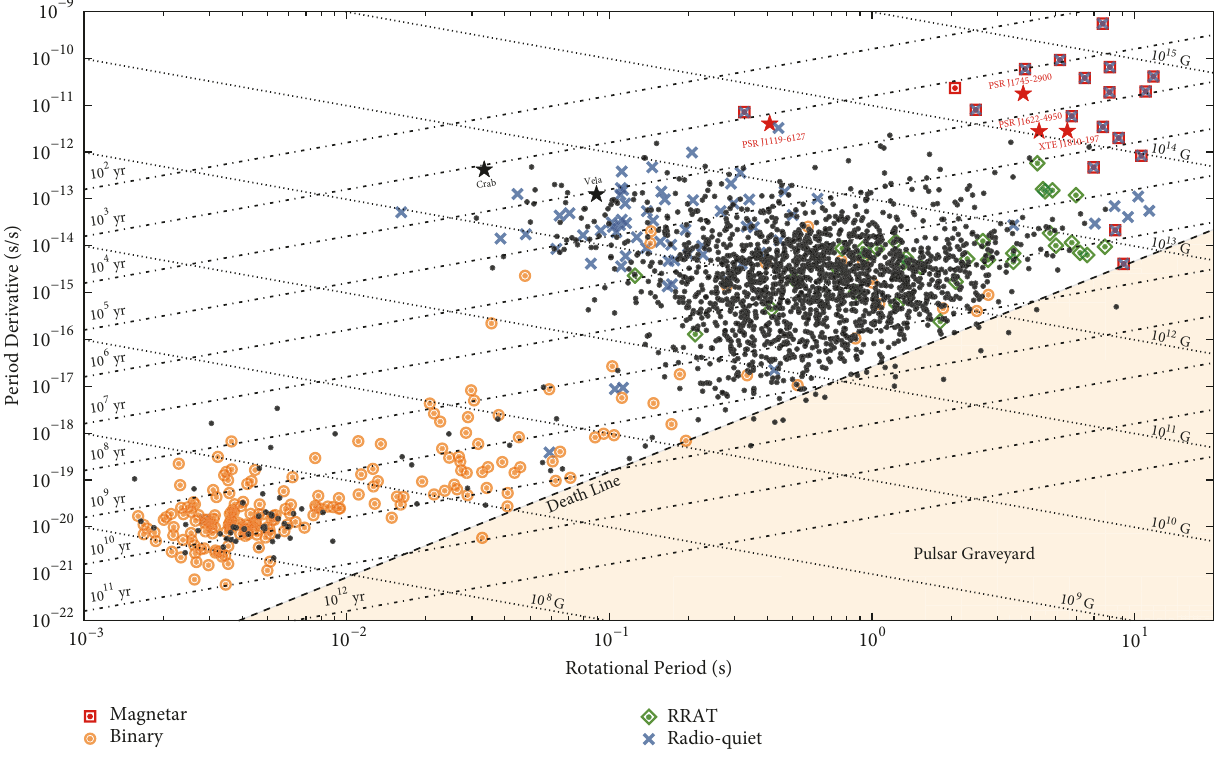
Magnetar Binary ̇𝑃 1: P – diagram of pulsars in the Telescope (see https://www.atnf.csiro.au/people/pulsar/psrcat) [36]. The four radio magnetars, PSR J1745–2900, PSR J1119–6127, PSR J1622–4950, and XTE J1810–197, discussed in this paper are labeled using red stars. Magnetars (red squares), rotating radio transients (RRATs; green diamonds), and millisecond pulsars (MSPs; orange circles) are also shown, along with the population of rotation-powered radio pulsars (black circles). Radio-quiet pulsars are indicated with blue crosses and include many of the magnetars shown in red. Lines of constant magnetic field and characteristic age are derived assuming a constant braking index of 𝑛 = 3 . The radio pulsar death line is given by the model in Equation (4) of Zhang et al.